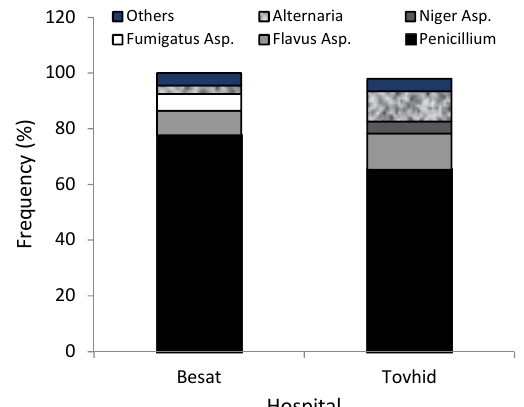
Fig. 3. Distribution of fungi in the hospital during the study